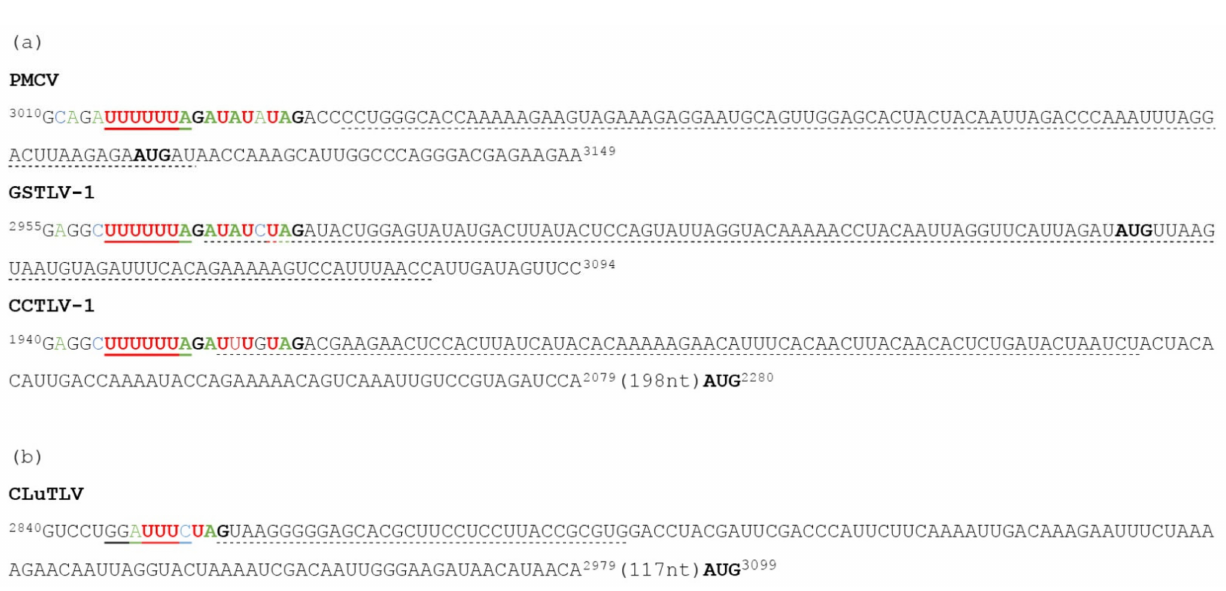
Figure 2. Characteristics of sequences related to ribosomal frameshift for translation of ORF2 as a C-terminal fusion protein with the ORF1 encoded protein. Nucleotides in 3’ end of ORF1 are color coded. ( a ) PMCV, GSTLV-1 and CCTLV-1. Preserved nucleotides are shown in bold and heptameric nucleotide slippery sequences are underlined. ( b ) Suggested slippery sequence in CLuTLV genome underlined. For all, ORF1 stop codon (UAG) and first possible start codon (AUG) of ORF2 if expressed non-fused to ORF1, are shown in bold. Sequences predicted to result in pseudoknots by dotted underlining (KnotInFrame predicted: PMCV, GSTLV-1 and CCTLV-1 in ( a ), HPknotter predicted: CLuTLV in ( b ). Numbers on sequences refer to position in full length